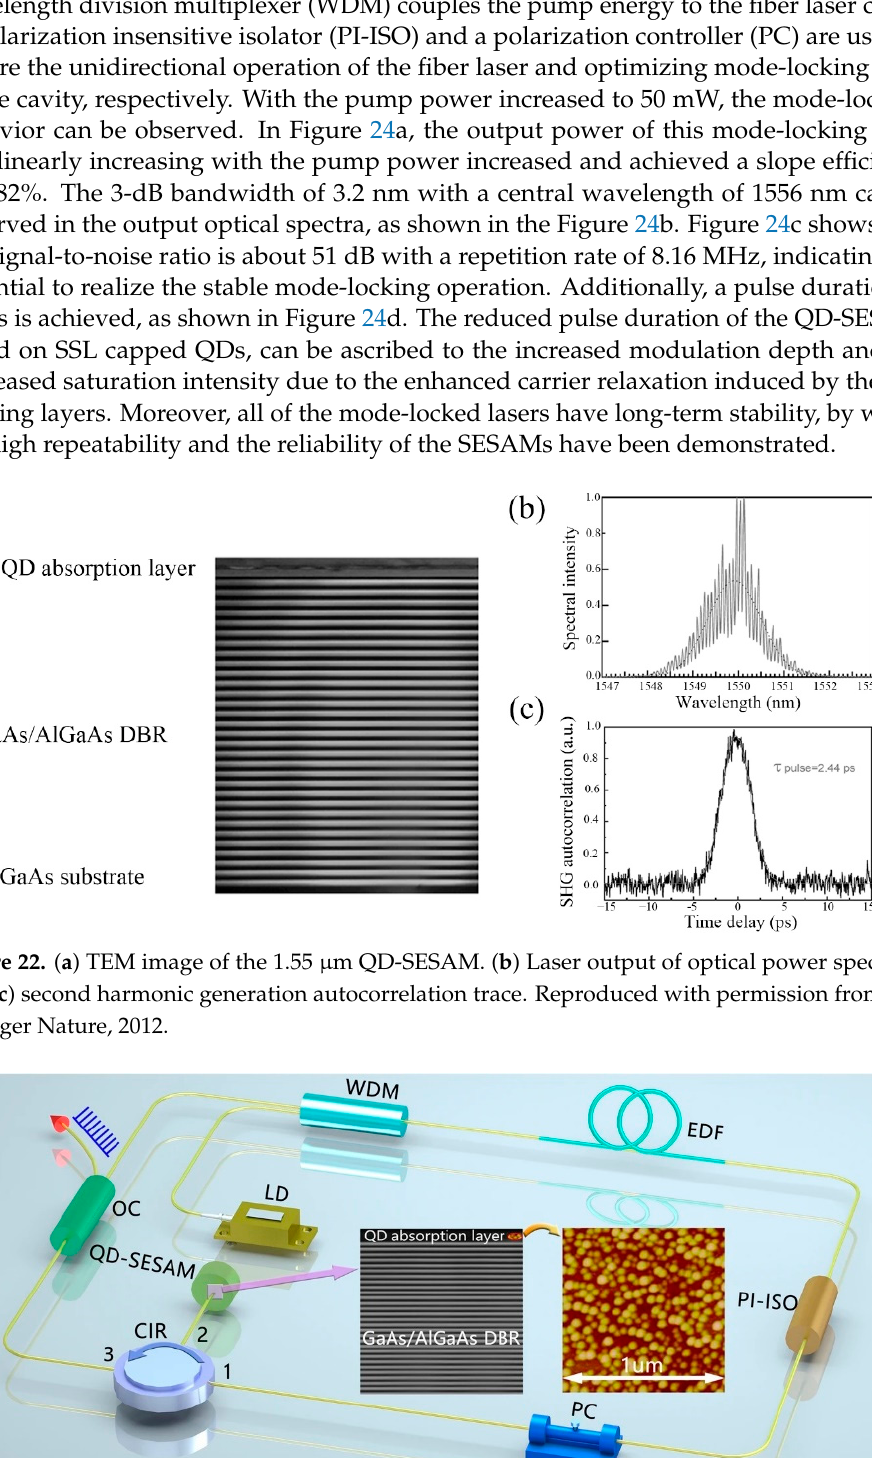
Figure 23. Experimental setup of mode-locked fiber laser with 1550 nm SESAM. Inset: TEM image of the QD-SESAM and AFM image of the 1550 nm QDs. Reproduced with permission from [192]. Springer Nature, 2019.